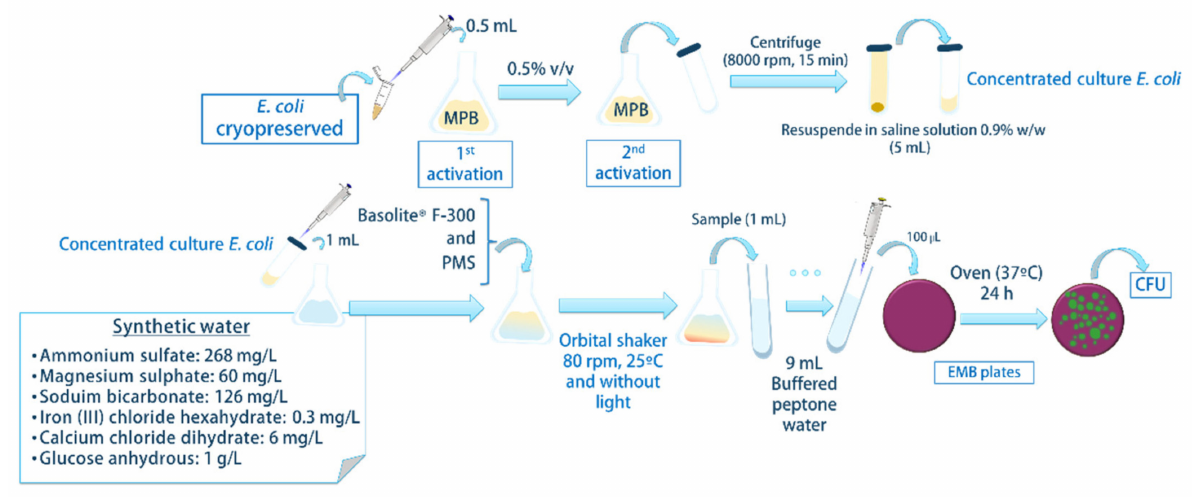
Figure 1. Scheme of the experimental procedure of E. coli